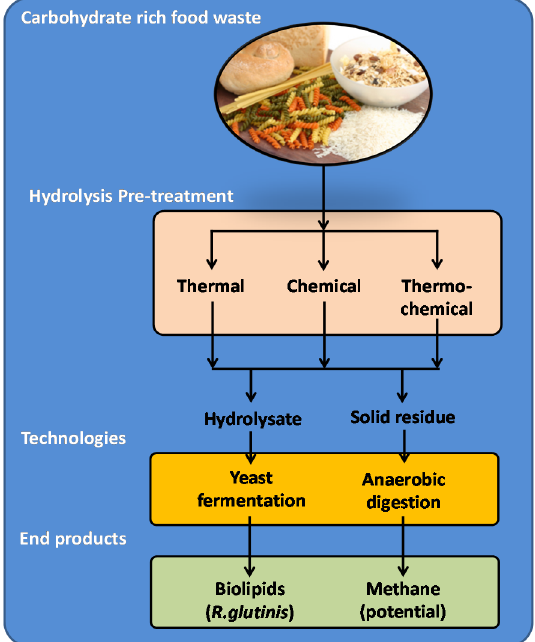
Figure 1. Proposed integrated bio-refining approach for carbohydrate-rich food waste recycling for